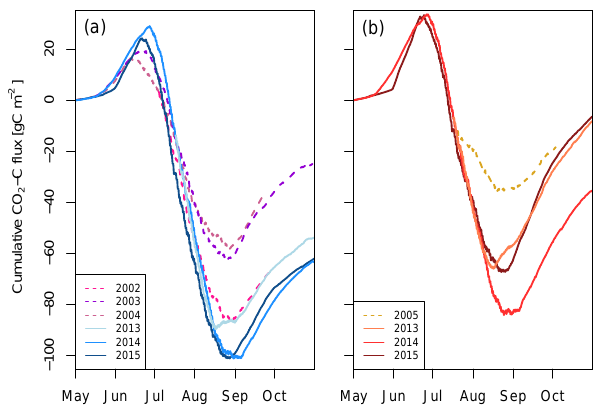
Figure 7. Recent (2013–2015) and historic (2002–2005) cumulative CO 2 budgets separated into disturbance regimes: (a) control area; (b) drained area.